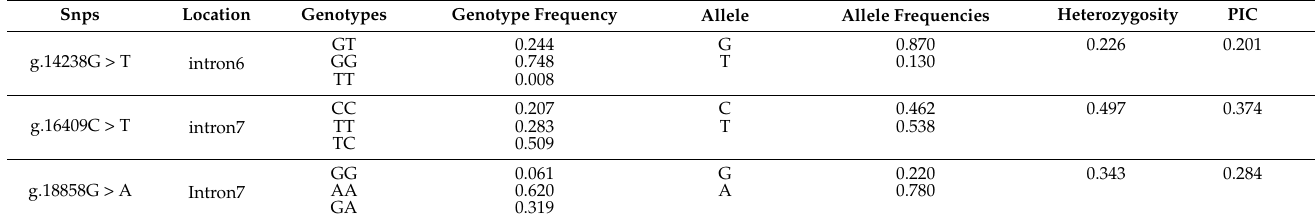
Table 1. Genetic information about five SNPs identified in the buffalo SQLE